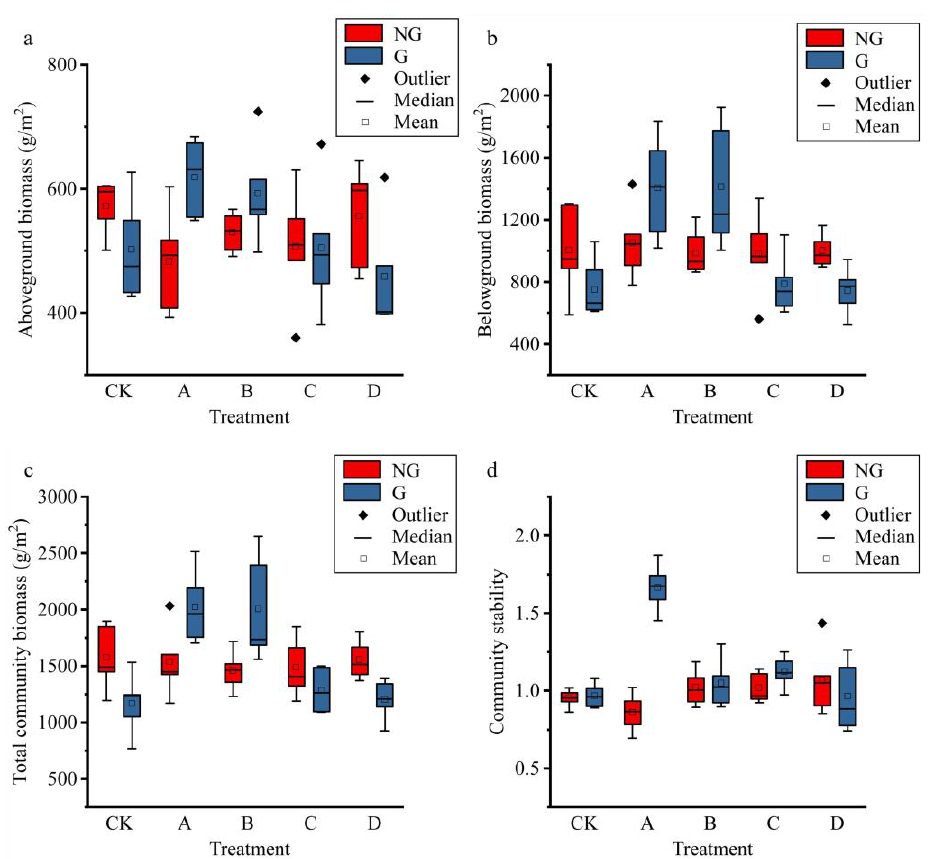
Figure 4. Effects of gradient warming and grazing on ecosystem functioning. ( a ), aboveground biomass of plants; ( b ), belowground biomass of plants; ( c ), total biomass of plants; ( d ), structural stability of plant community. The horizontal axis indicates the experimental treatments that resulted in different warming gradients. NG and G indicate treatments without simulated grazing and treatments with grazing, respectively.